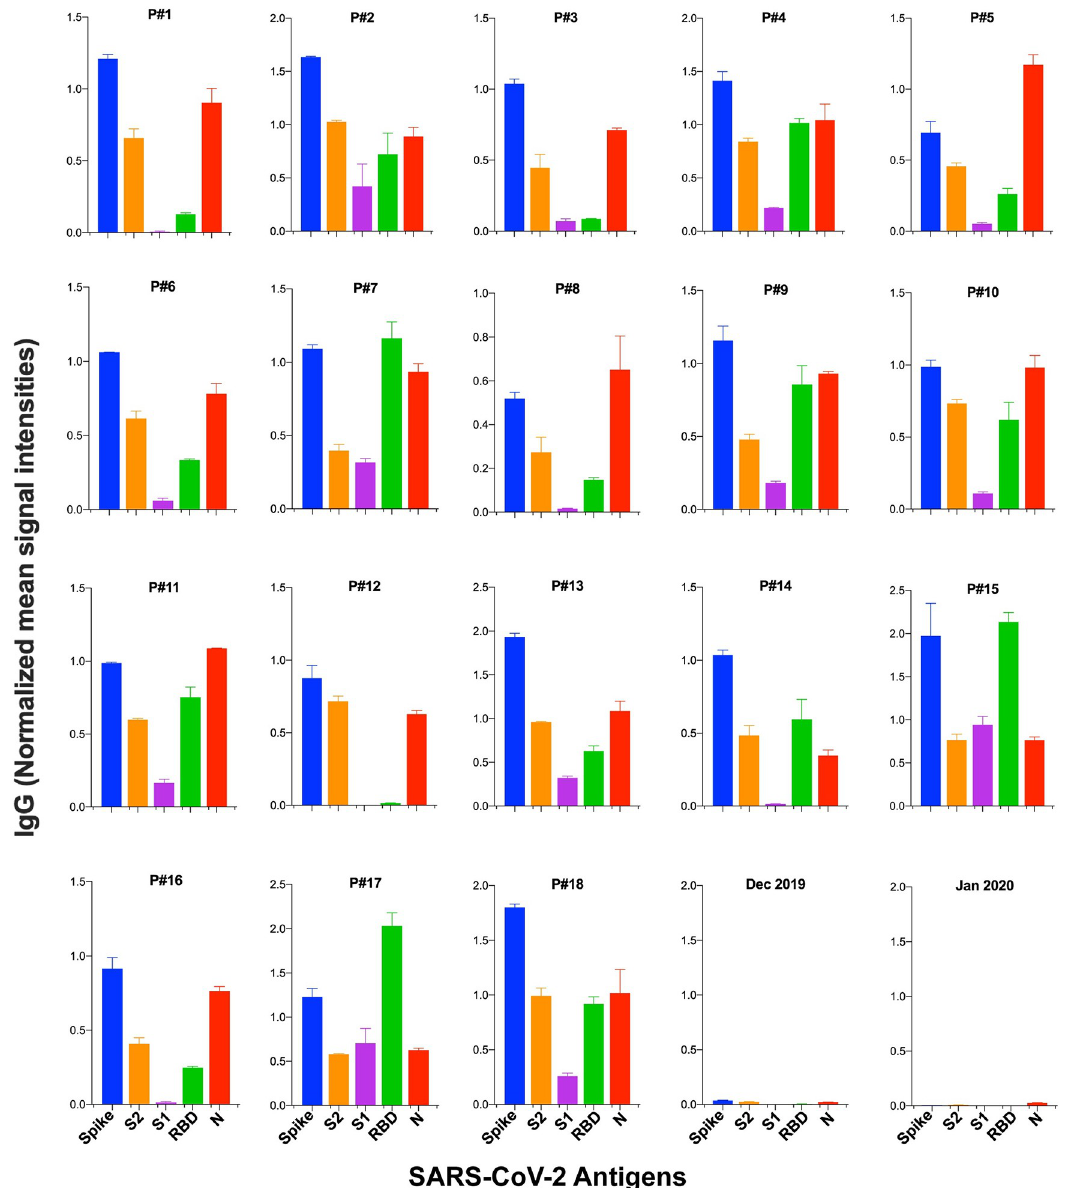
Fig 3. Serum IgG levels against SARS-CoV-2 antigens in COVID-19 patients. Serum IgG levels are shown against spike, its domains (S1, S2, RBD) and nucleocapsid (N) for 18 patients sera (P#1–18) and 2 control plasma samples. Signal intensities are normalized to human IgG isotype control for each sera/plasma and mean values ± SD are calculated for duplicates. The data is shown for a single dilution (1/270) and 7.2 fmol antigen concentration.